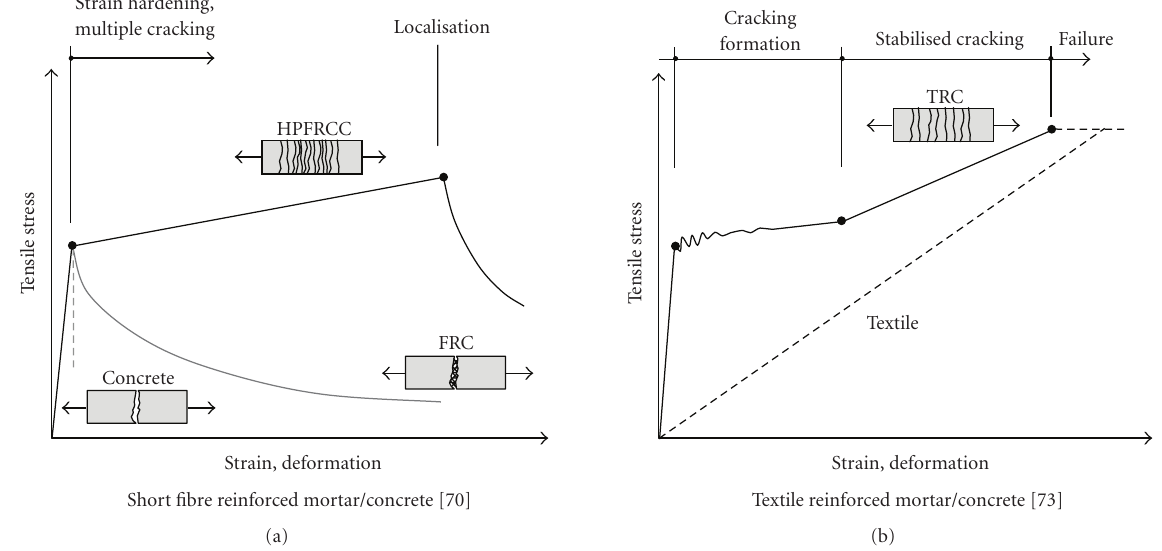
Figure 4: (a) Strain hardening and strain softening mortars. (b) Tensile behaviour of